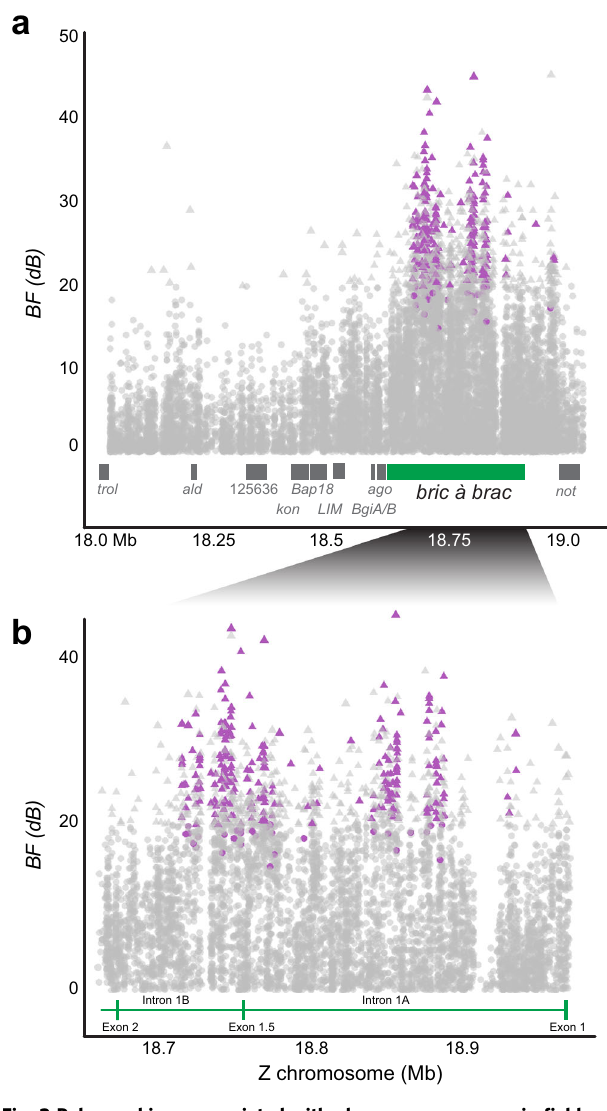
Fig. 3 Polymorphisms associated with pheromone response in fi eld populations. Bayes factor (BF) for polymorphism (SNP, indel, SV) association with pheromone trap after accounting for population structure plotted along the Z chromosome (in Mb). a Male Resp QTL region with candidate genes (gray) and bab (green). b The fi rst intron of bab . ( a , b ) Bayes factor (BF) > 20 dB (triangle) and eBP is > 2 (purple) indicate the strongest evidence for an association. Vertical green lines indicate bab exon boundaries, including rare splice variant exon 1.5. Note orientation is opposite of Fig.